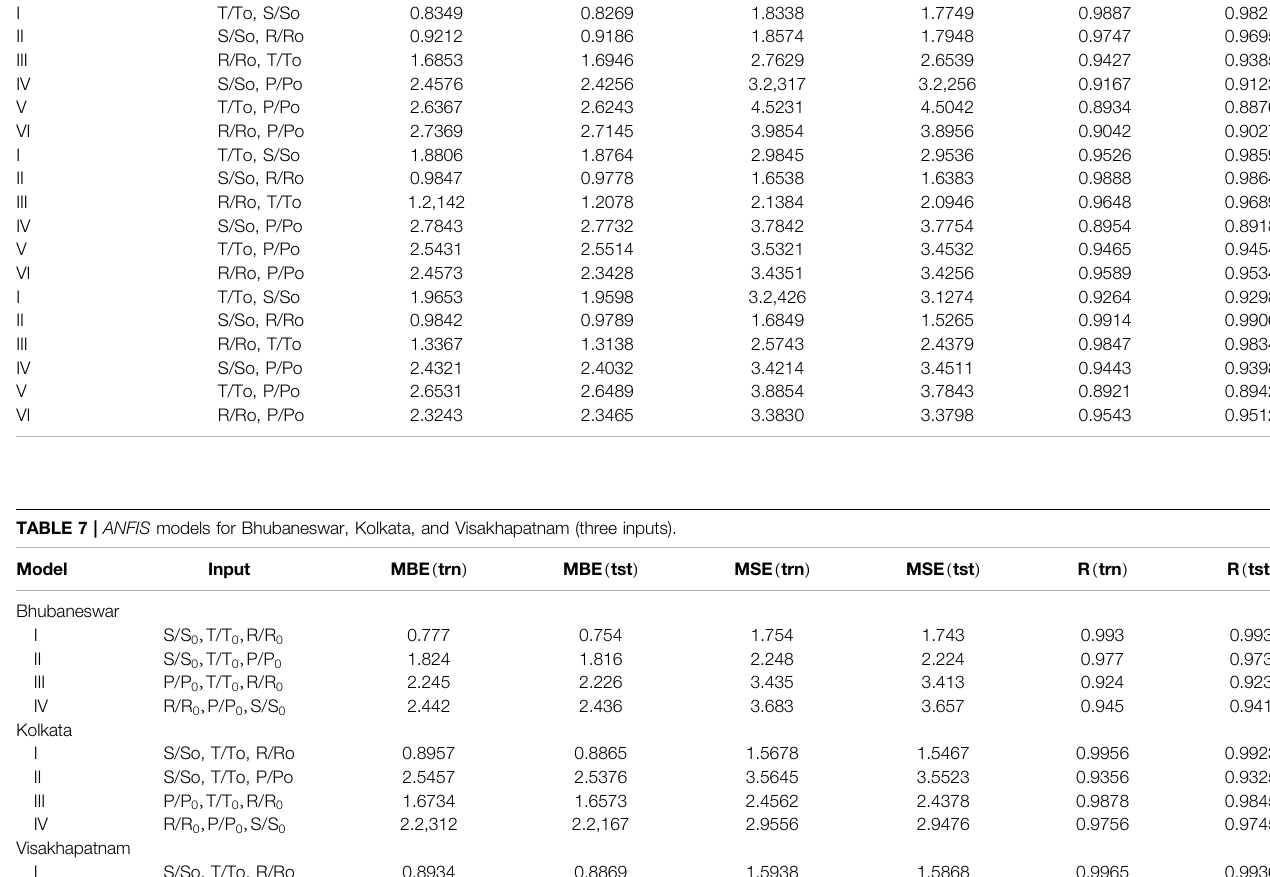
TABLE 6 | ANFIS models for Bhubaneswar, Kolkata, and Visakhapatnam (two inputs). ANFIS model